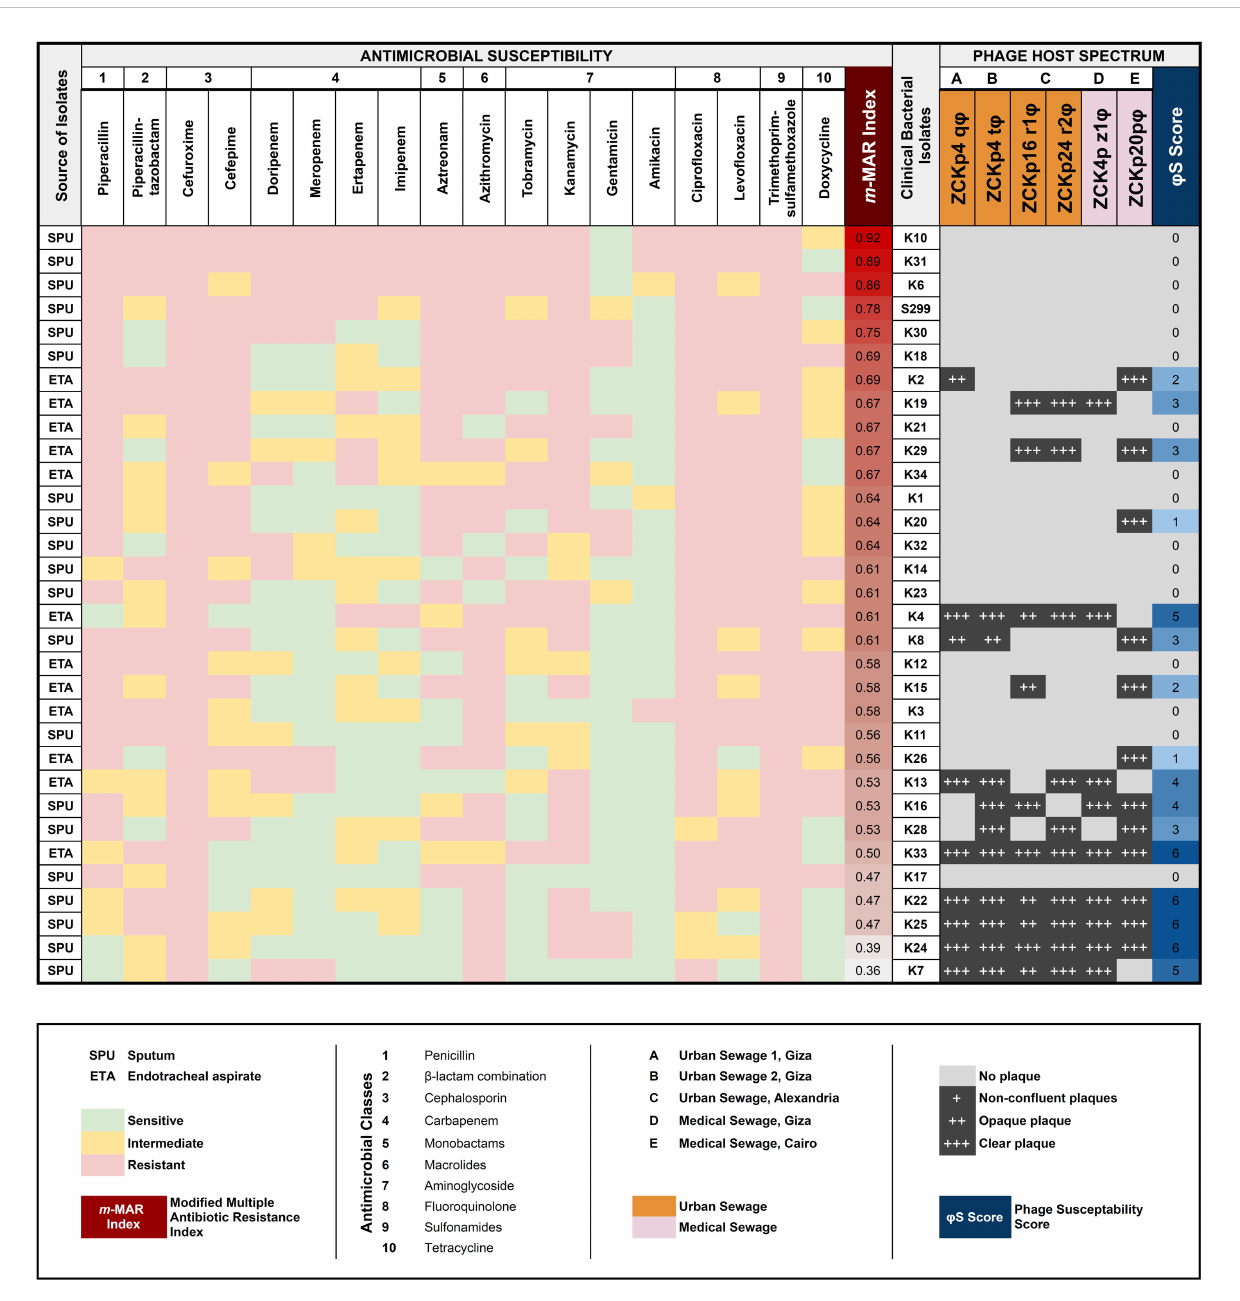
FIGURE 2 Antimicrobial and phage susceptibility pro fi le of bacterial isolates. A heatmap of the antimicrobial pro fi le of each bacterial isolate against 18 antimicrobial agents of 10 classes, with the estimated modi fi ed-MAR index for all isolates. The sources of isolated bacteria (SPU = sputum; ETA = endotracheal aspirate) are indicated in the leftmost column. In a grayscale matrix, the host range of each of the isolated phages is presented according to the plaque clarity (non-con fl uent plaque [+] to clear plaque [+++]) against the bacterial isolates. The host range of each phage is given a score (represented as a blue shaded gradient) that re fl ects the number of susceptible host isolates. The isolated phages are color-coded according to their source of isolation. A partial negative correlation is observed between the bacterial resistance of an isolate and its susceptibility to phage infection (Spearman rank correlation coef fi cient r s = - 0.6139, P =